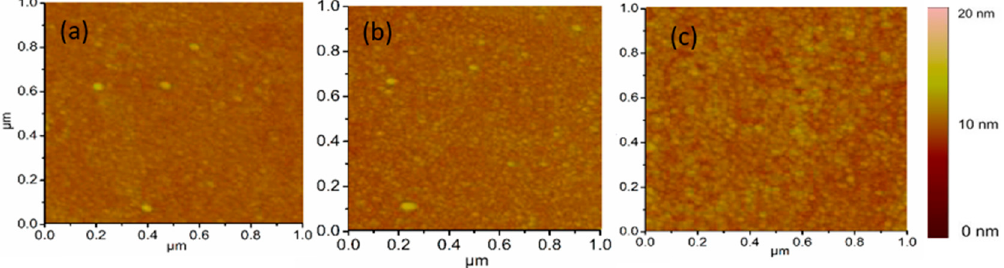
Figure 6. Atomic force microscopy (AFM) image of InGaZnO film at different content ratio, PA (In2O3):(Ga 2 O 3 ):(ZnO) content is ( a ) 6:1:3, ( b ) 7:1:2, ( c ) 7.5:1:1.5.